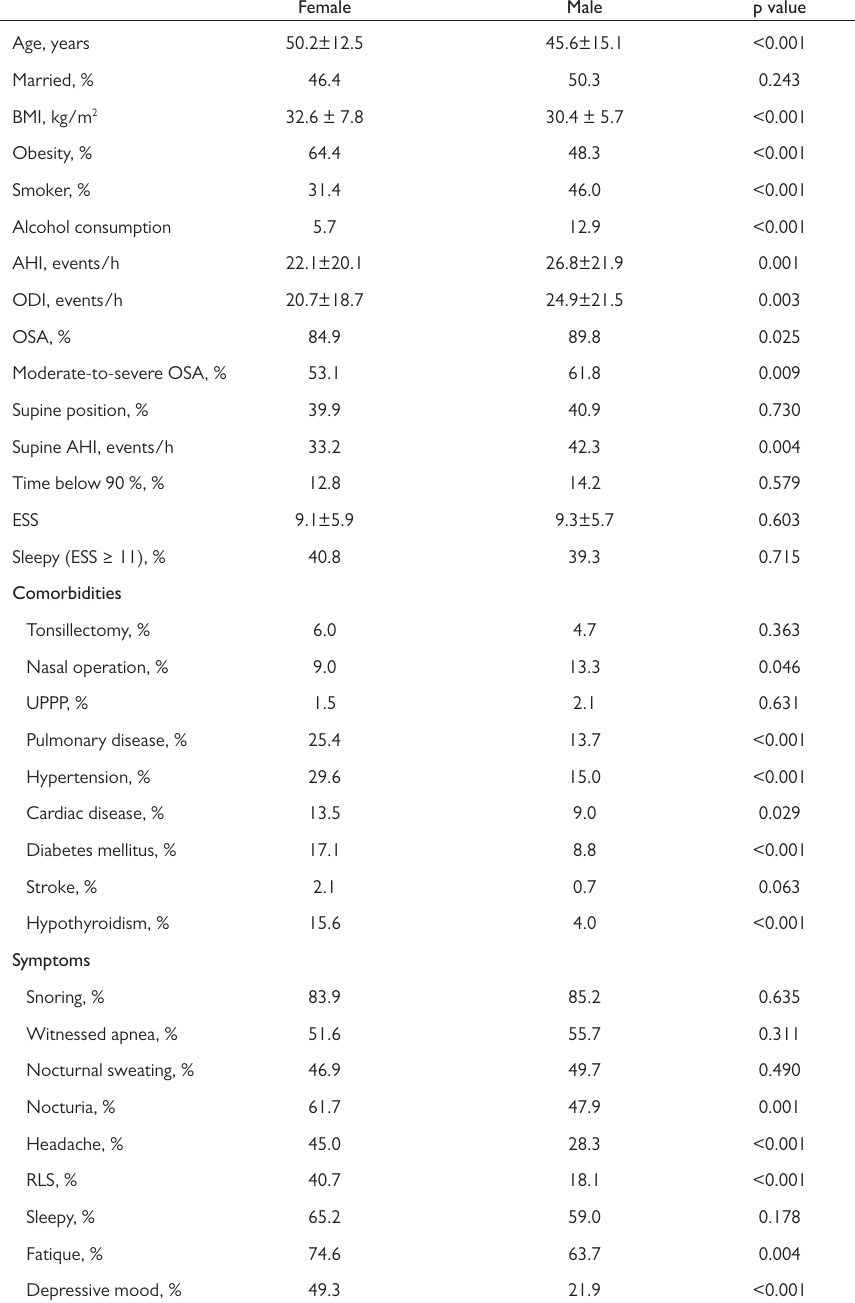
Table 1. Baseline clinical characteristics of the study population